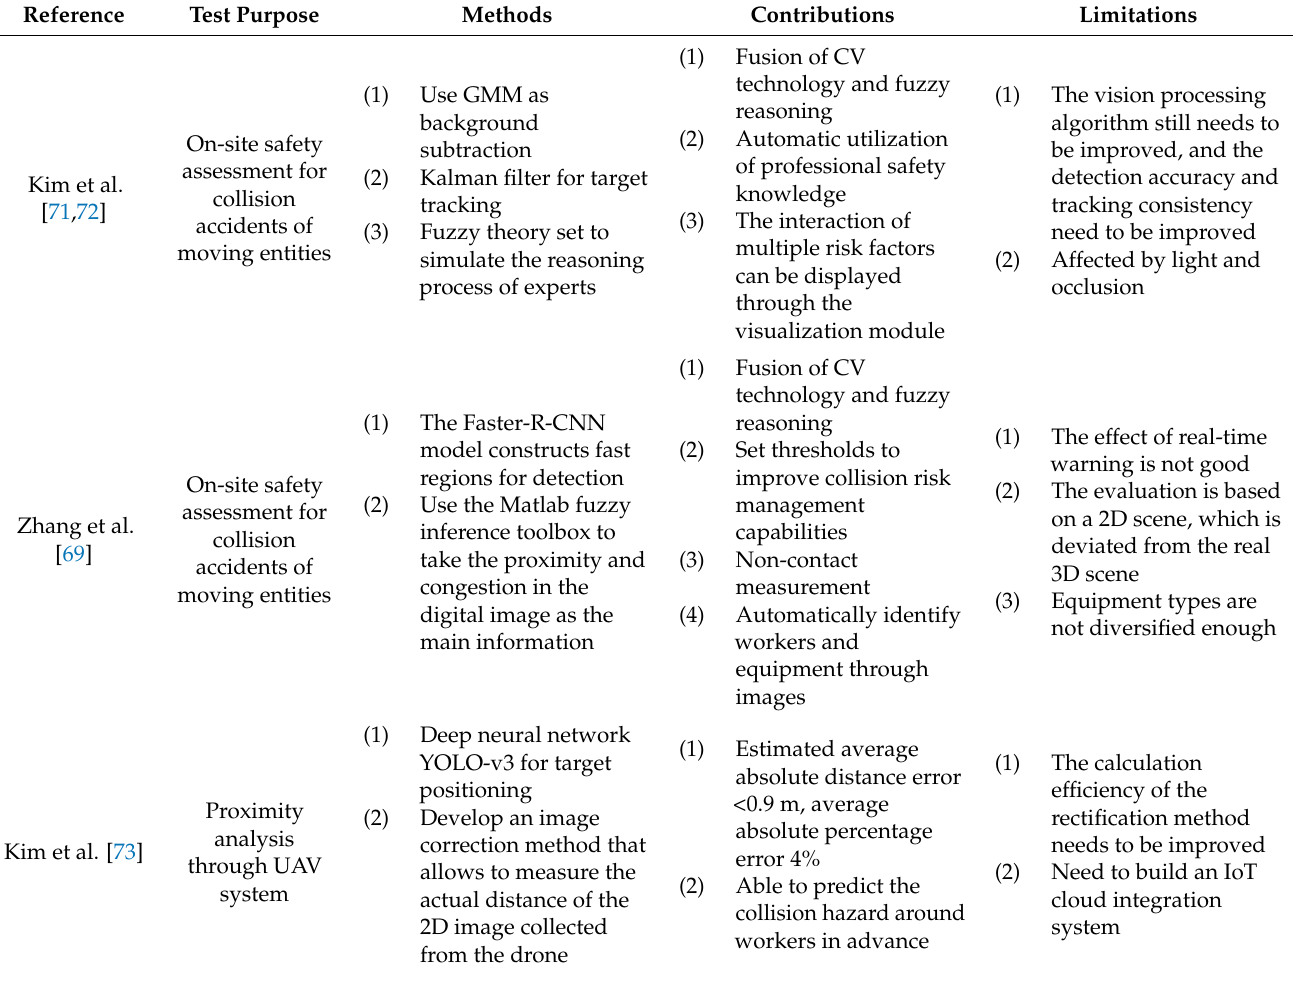
Table 3. Research details of collision between workers and construction